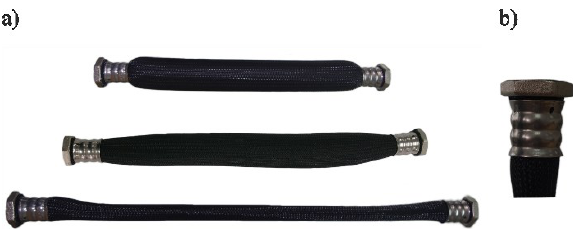
Fig. 2. The pneumatic artificial muscles PAM made at the Kielce University of Technology: a) general view, b) connection.